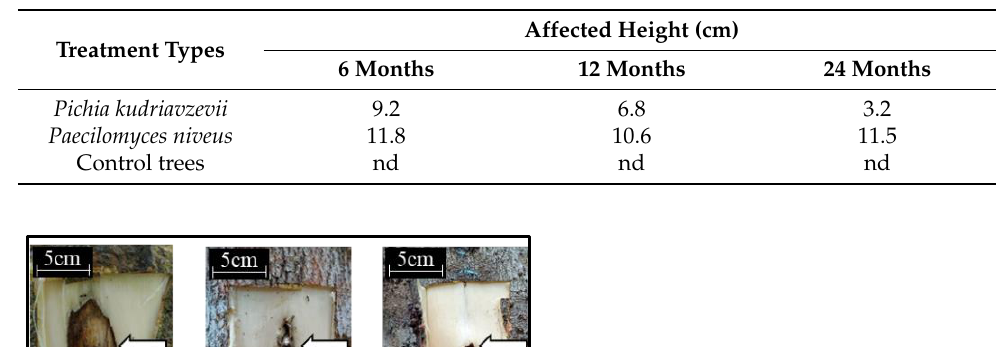
Table 4. Measurements on the area affected by the inoculation treatment in a given month.